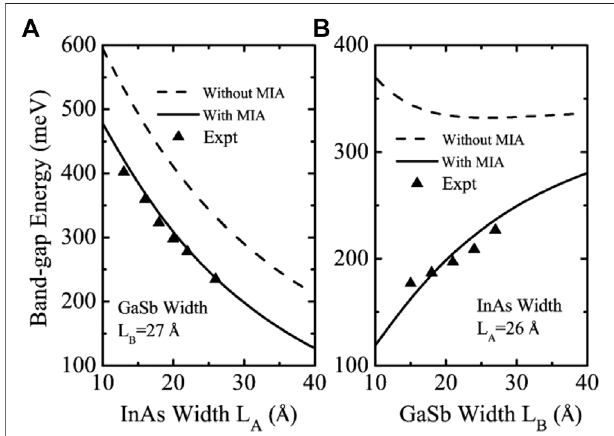
FIGURE 4 | Band-gap energy calculated without the MIA (dashed line) and with MIA (solid line) and measured (black symbols) bandgaps the of symmetrical 10 ML InAs/10 ML GaSb SL (R = 1) on a GaSb substrate at 77 ° K plotted as functions of the SL period